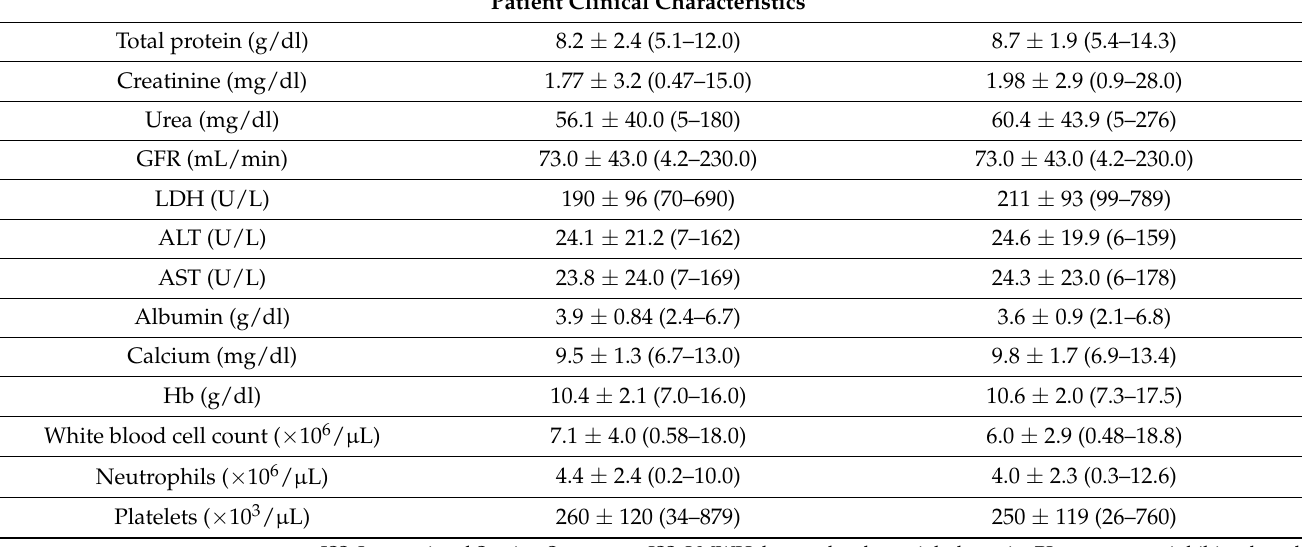
Table 1. Cont. Patient Clinical